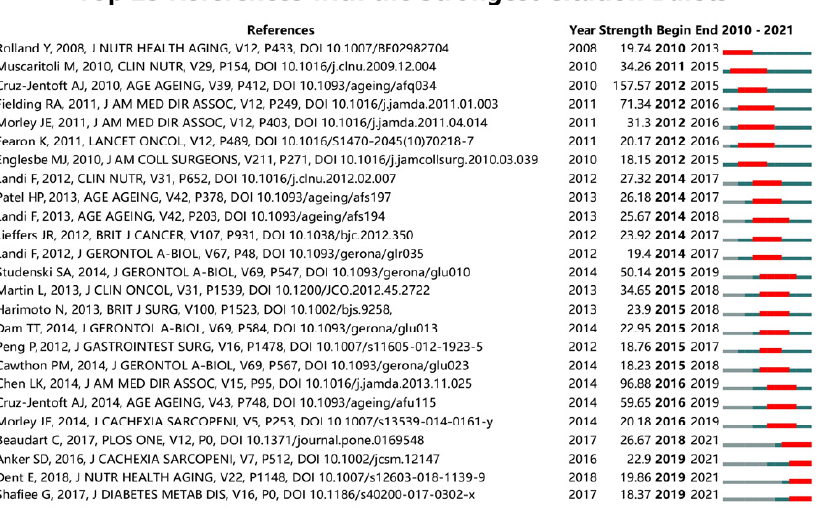
Figure 8. The 25 references with strongest citation bursts between 2010 to 2021; the red bars represent the duration of bursts [9–11,13,14,29–48] .